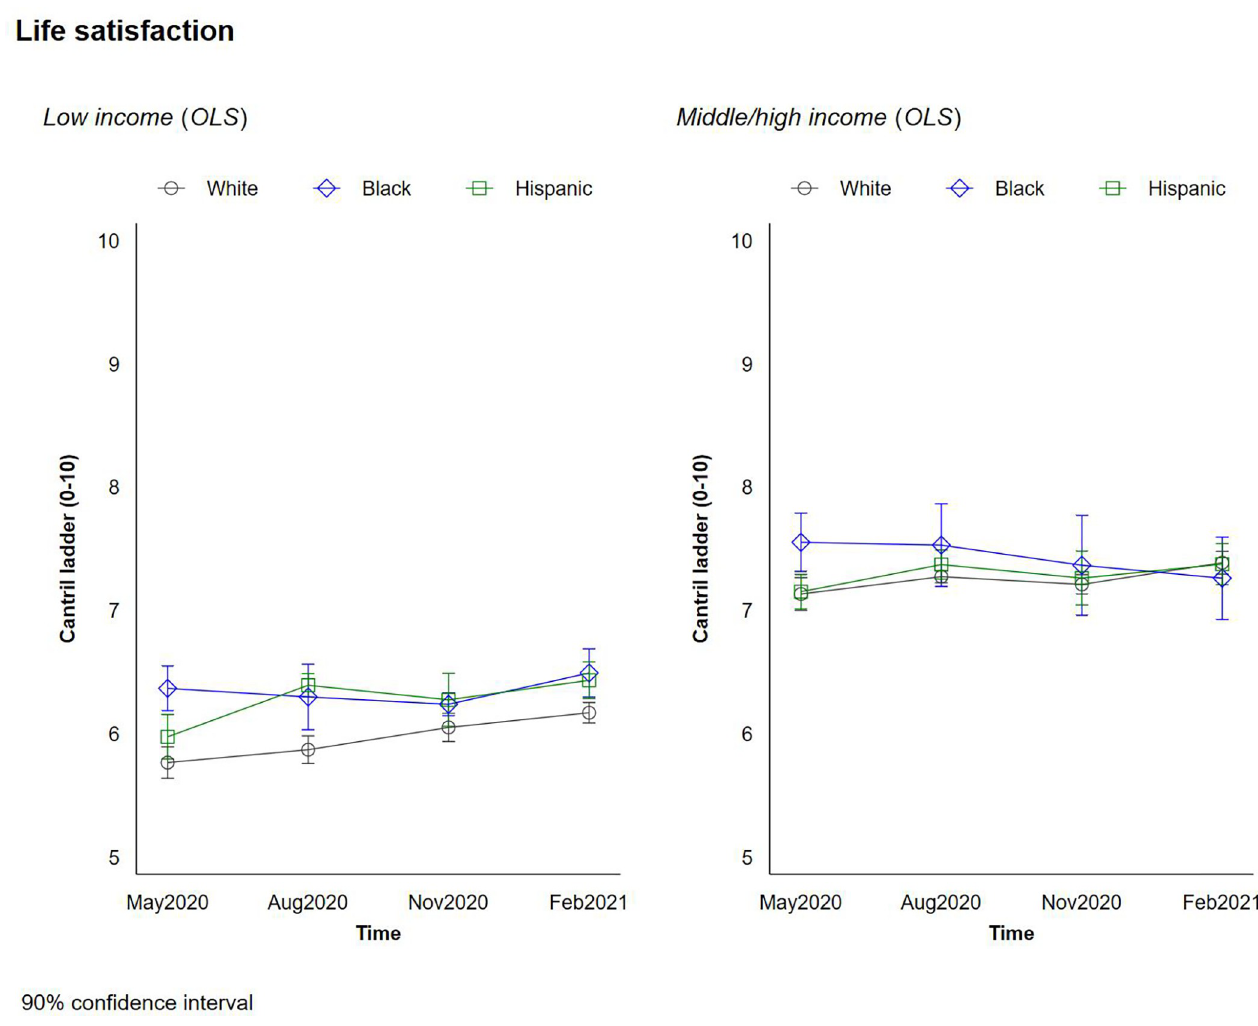
Fig 2. Changes in life-satisfaction by race and